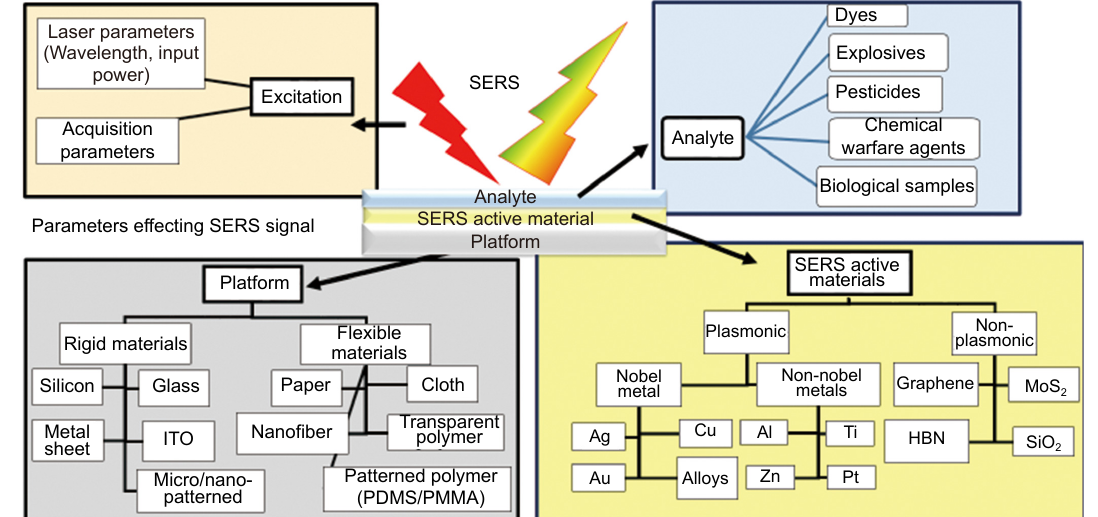
Fig. 1 | A schematic depicting the various parameters influencing the SERS